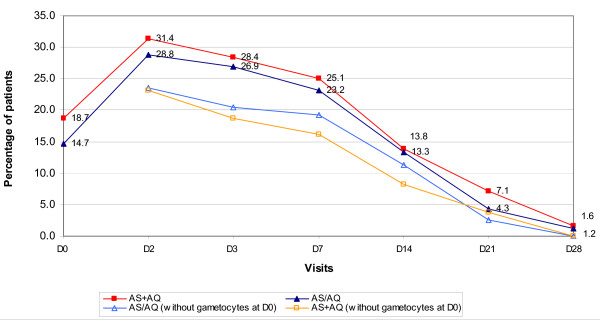
Proportion of patients with gametocytes at baseline and during follow up.